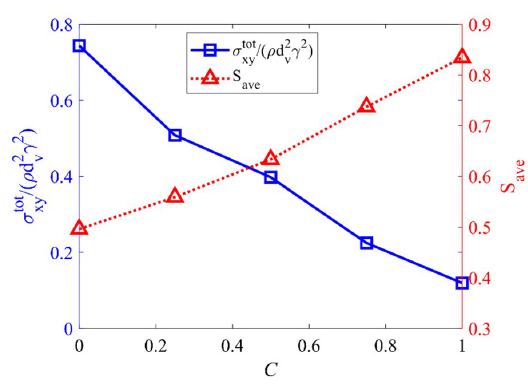
Figure 11. The average normalized shear stress and the average order parameter S ave as a function of rods fraction C for binary mixtures of AR = 0.3 and AR = 6, solid volume fraction ν = 0.5.